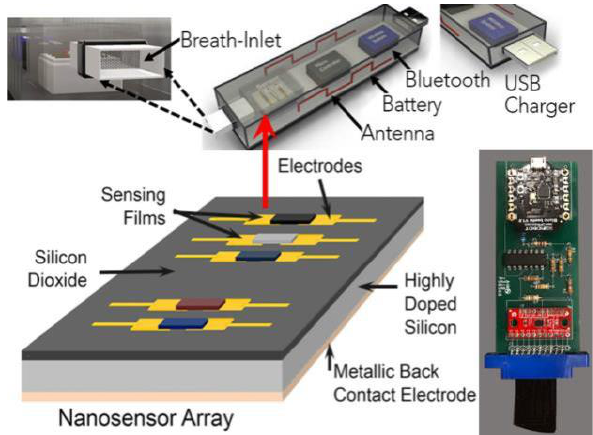
Figure 1. Illustrates the nanosensor array and device configuration with breath-inlet, antenna, battery, Bluetooth, and